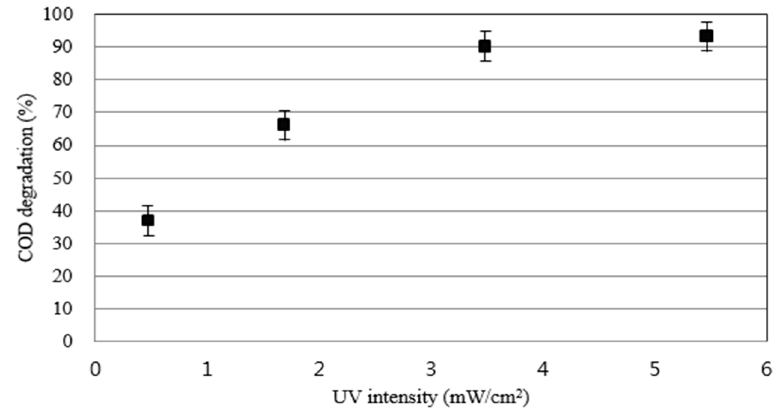
Figure 6. Effect of UV light intensities on COD removal in photo-assisted Fenton oxidation (pH = 3.5, Fe 2+ = 0.01 M, H 2 O 2 = 0.1 M).